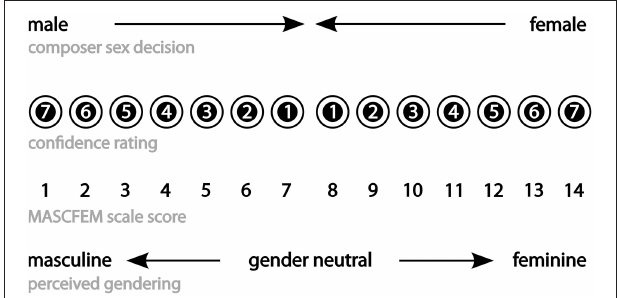
FIGURE 3 | Structure of the MASCFEM scale: perceived masculinity/ femininity of extracts and performance.